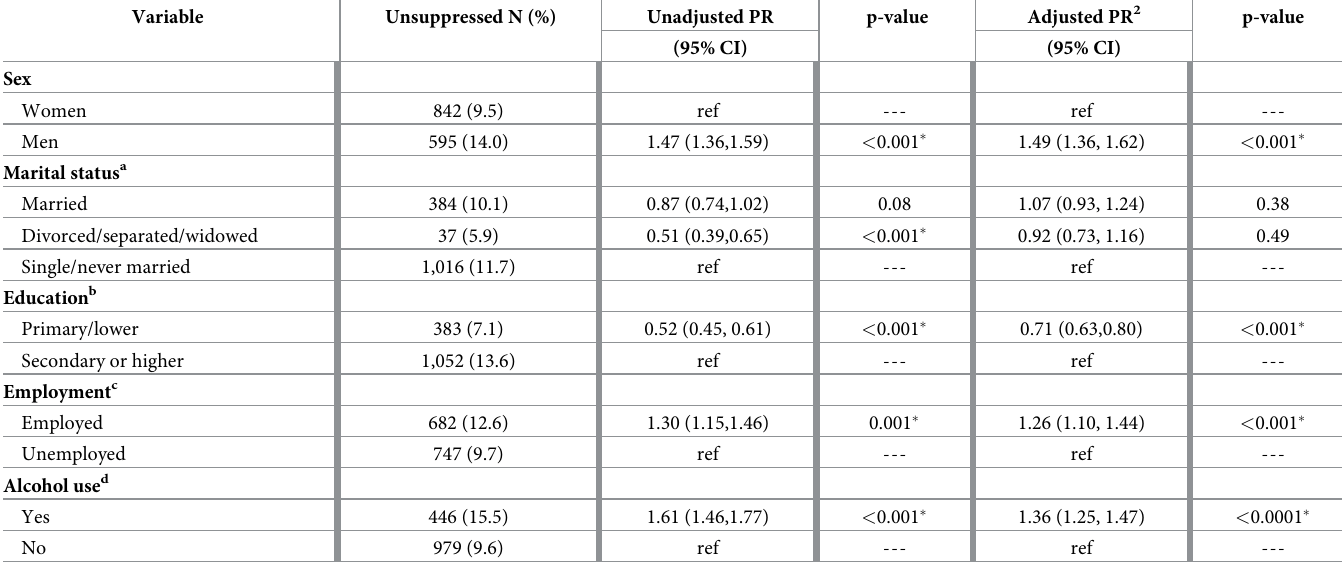
Table 3. Factors associated with no viral suppression at study end in the intervention communities, n = 13,124 1